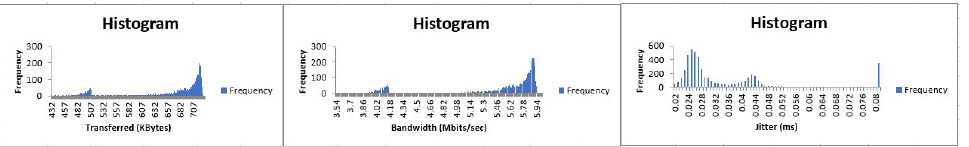
Figure 9. Node 1 with file transfer size of 16 bits with utilized bandwidth and